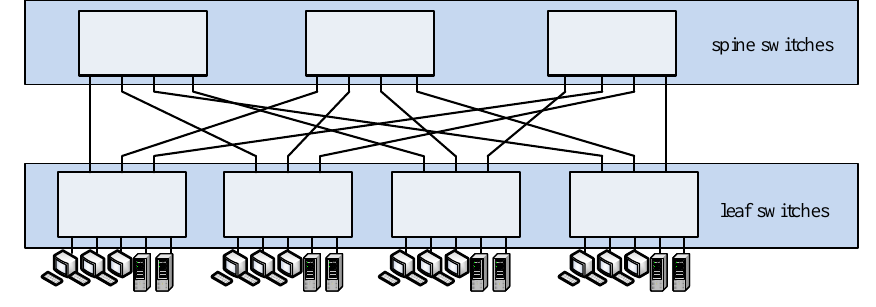
Figure 3. A three-stage Clos topology of a data center.